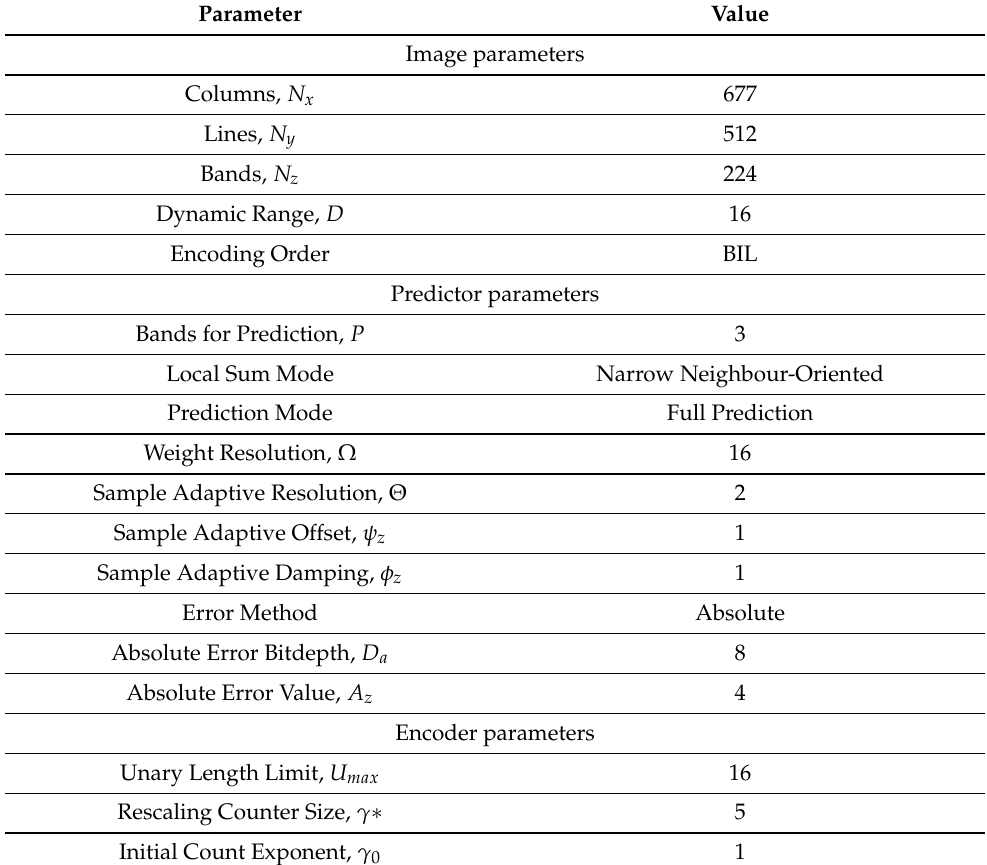
Table 2. Main configuration parameters of the CCSDS 123.0-B-2 proposed solution used for synthesis